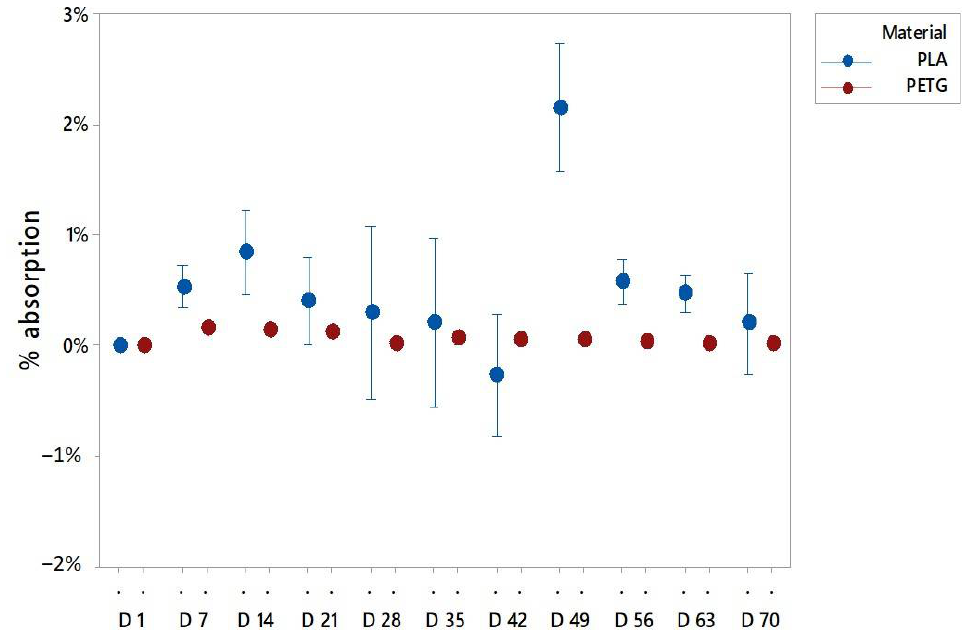
Figure 6. Water absorptions of PLA and PETG specimens in a fully saturated solution with distilled water and sugar, where D is the day of the evaluation of absorption .